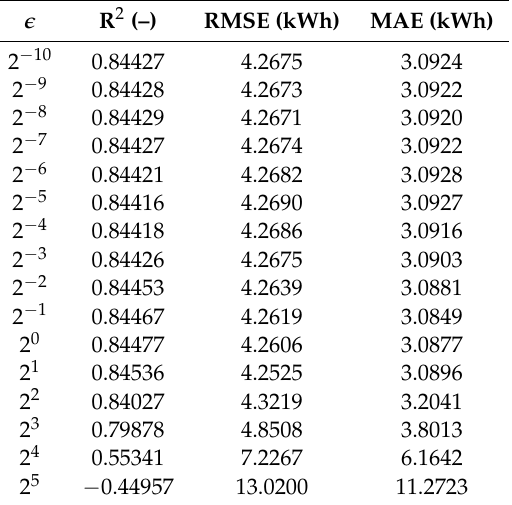
Table 6. Results of different (cid:101) , where C = 2 5